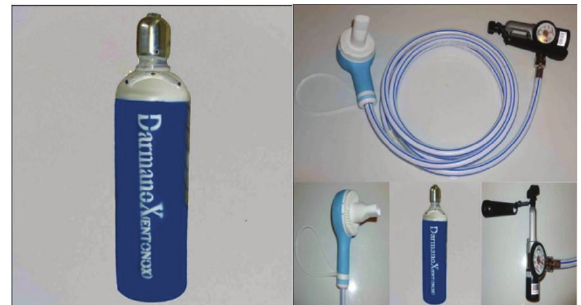
Figure 1: Darmanox capsule and giving set which were used in this study.